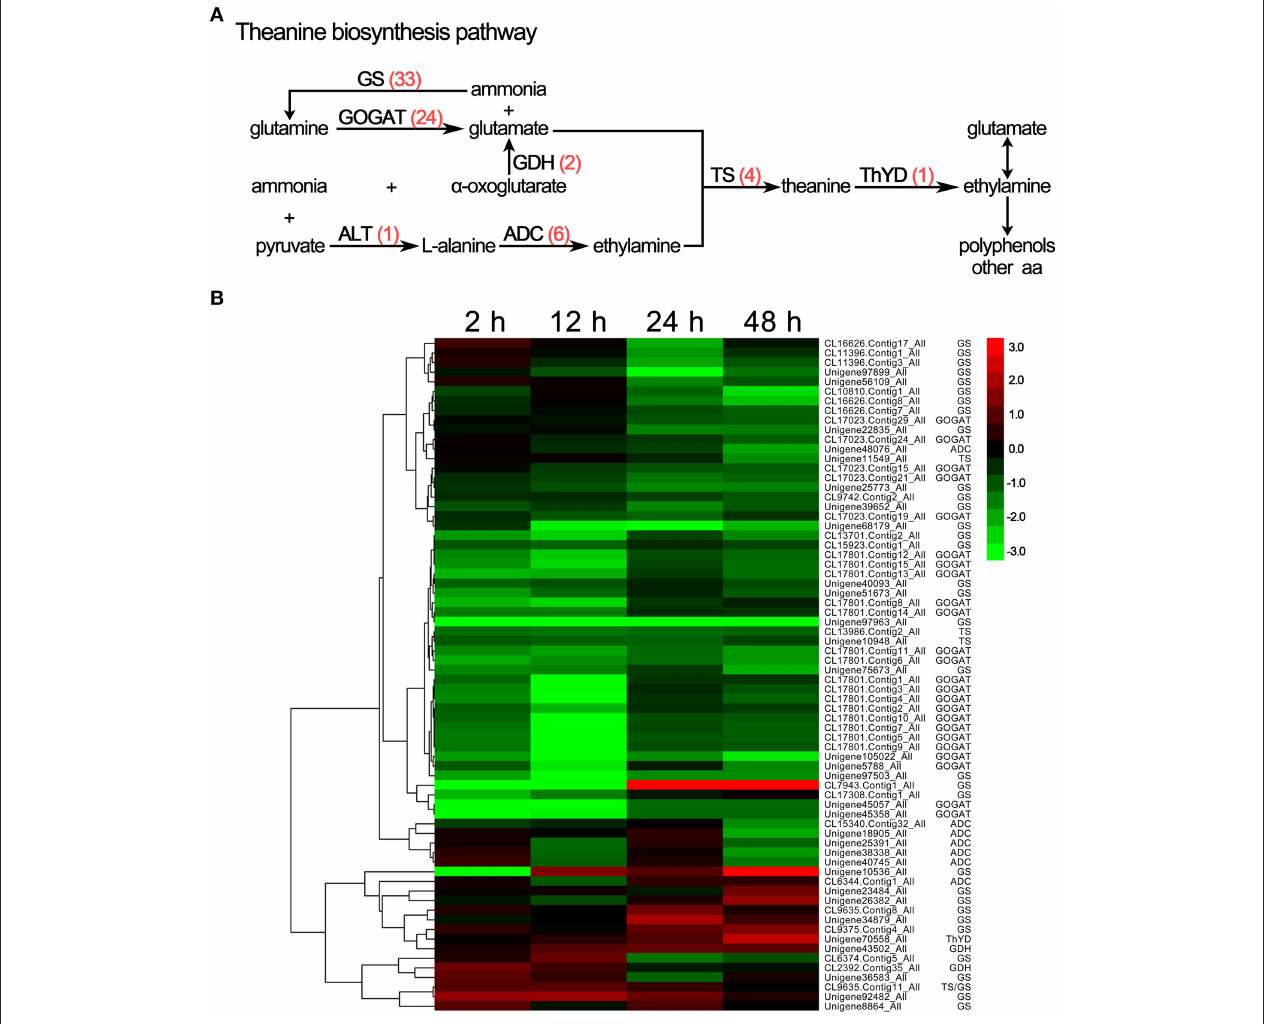
FIGURE 7 | DEGs involved in theanine biosynthesis in C. sinensis leaves under drought stress. (A) The theanine biosynthesis pathway. The red numbers in parentheses following each gene name indicate the number of corresponding DEGs. GS, glutamine synthetase; GOGAT, glutamate synthase; GDH, glutamate dehydrogenase; ALT, alanine aminotransferase; ADC, arginine decarboxylase; TS, theanine synthetase; ThYD, theanine hydrolase. (B) Hierarchical clustering analysis of the relative expression levels of the DEGs related to theanine biosynthetic. The FPKM ratio of unigene expression is represented on a logarithmic scale for each treatment period (2, 12, 24, or 48h) and the control (0h). Red indicates that a gene was up-regulated at that stage, whereas green indicates down-regulated